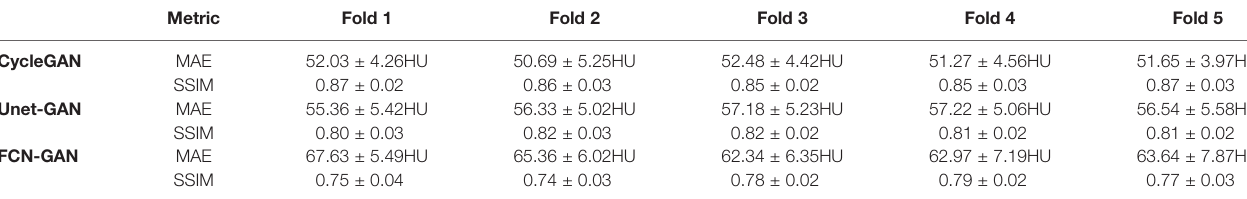
TABLE 1 | Metric results of MAE and SSIM computed between real CT image and different pseudo-CT images for fi vefold cross-validation. Metric